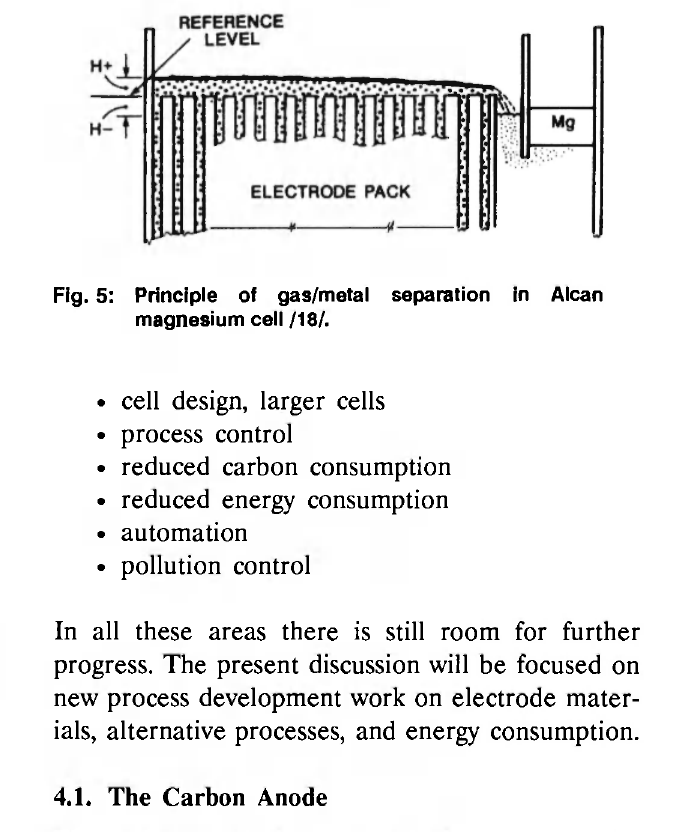
Fig. 4: Sketch of Norsk Hydro magnesium cell as illustrated in a patent /14/. Upper figure shows the metal collecting chamber to the right, while the lower figure shows a longitudinal section of the cell depicting the hollow cathodes.